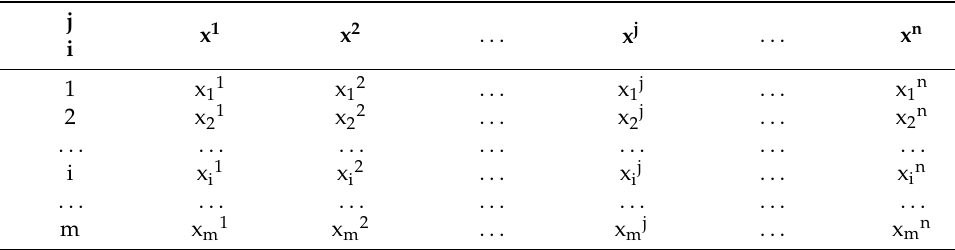
Table 1. Quantity of stocks.